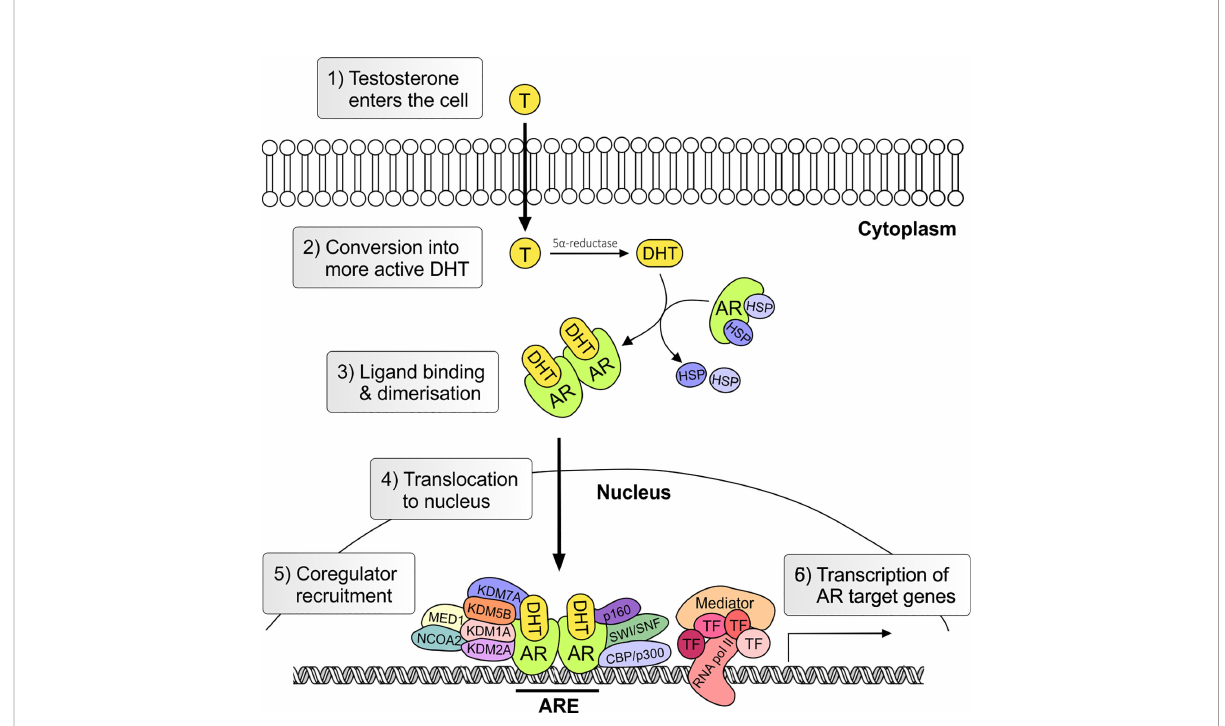
FIGURE 3 Genomic androgen receptor signaling pathway. Androgens, such as testosterone and dihydrotestosterone, enter the cell and are converted in the more active metabolite (5 a -DHT) by the steroid-5 a -reductase. Upon ligand binding heat stress protein (HSP) chaperones are released and AR undergoes conformational change and dimerization. In the nucleus the AR together with co-regulators activates the transcription of androgen regulated genes. T, testosterone; AR, androgen receptor; DHT, 5 a -dihydrotestosterone; HSP, heat shock; TF, transcription factor; ARE, Androgen Response